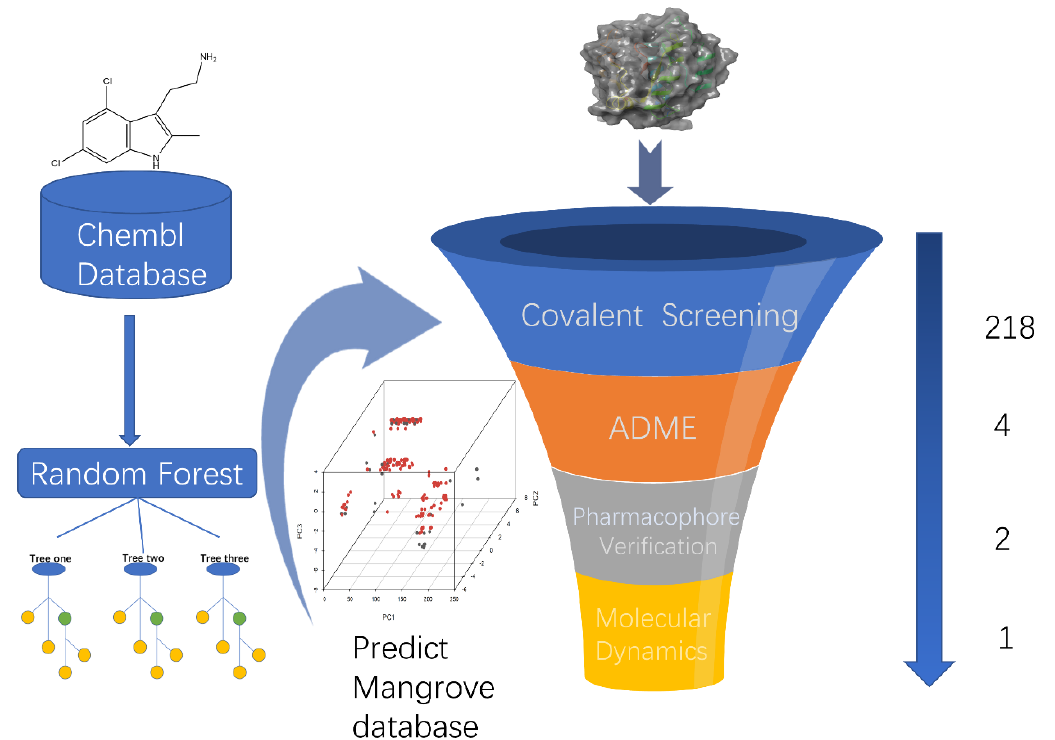
Figure 1. A virtual screening workflow (VSW) was used to identify molecules that hit KRAS G12C . A workflow overview of machine learning, covalent screening, elimination, and toxicity (ADMET) approaches for pharmacophore validation and MD simulations.